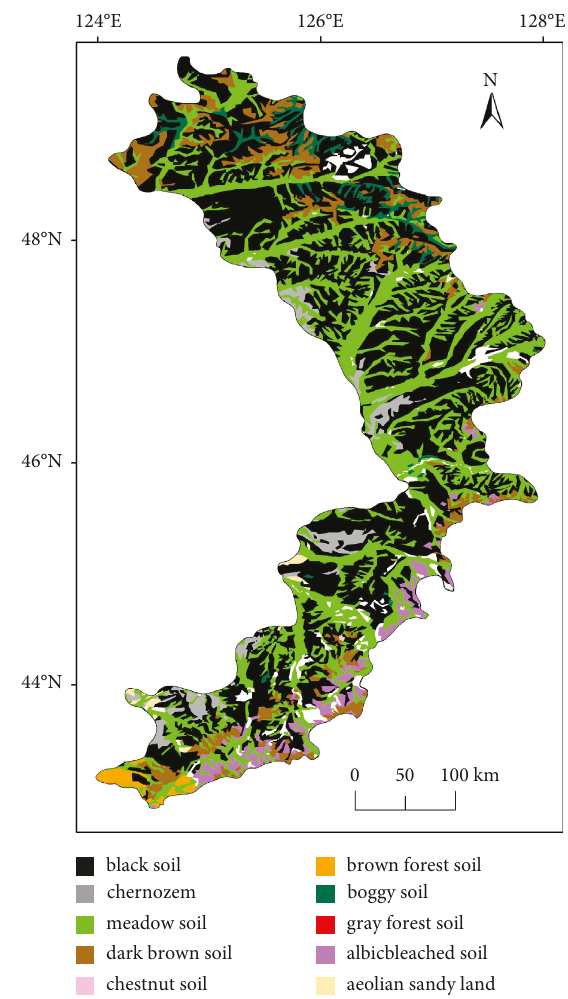
Figure 2: Soil types in the study